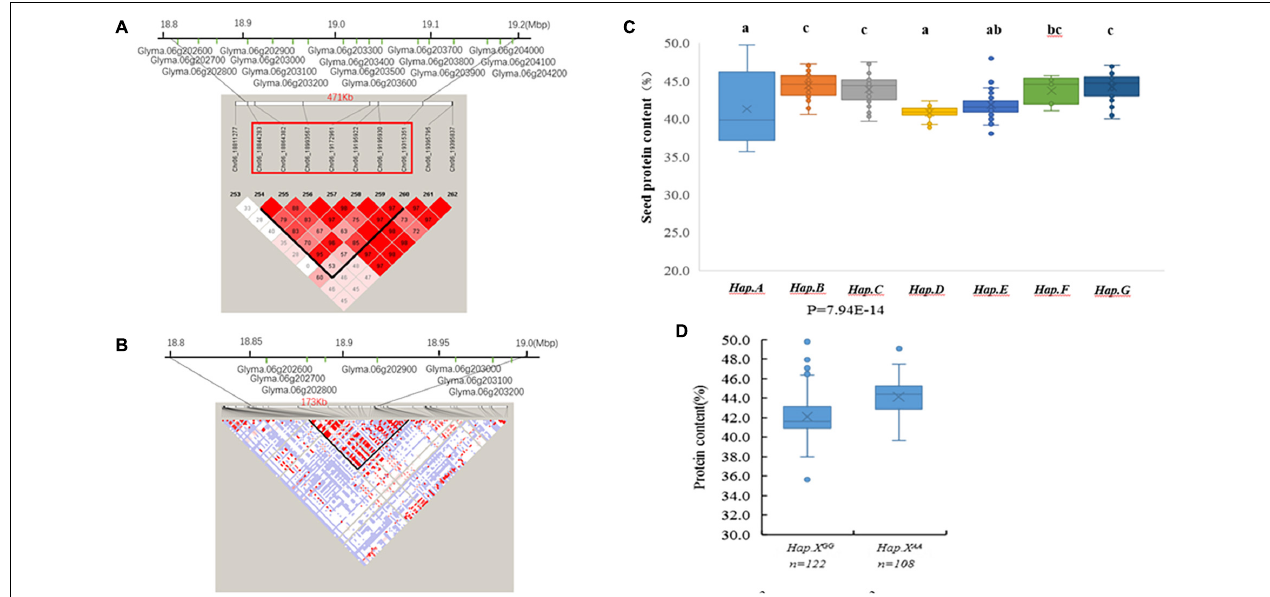
FIGURE 3 | (A) The extent of linkage disequilibrium (LD) in the regions based on pairwise r 2 values. The r 2 values are indicated using the color intensity index. Heatmap showing LD between each pair of markers that passed the Bonferroni threshold in genome-wide association study (GWAS). (B) Candidate genes for each single nucleotide polymorphism (SNP) locus. The bottom panel depicts the extent of linkage disequilibrium in the regions based on pairwise r 2 values. The r 2 values are indicated using the color intensity index shown. (C) Boxplot of seed protein based on different genotypes in soybean accessions. (D) Boxplot of seed protein based on Hap.X GG and Hap.X AA phenotypic differences between genotype combinations of the two